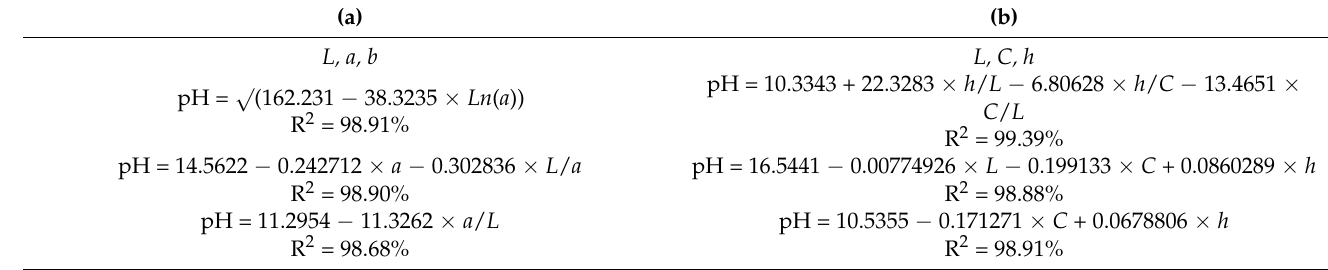
Table 3. The most significant relationships between pH and orthogonal (a) and cylindrical (b) CIELAB parameters according to the adjusted R 2